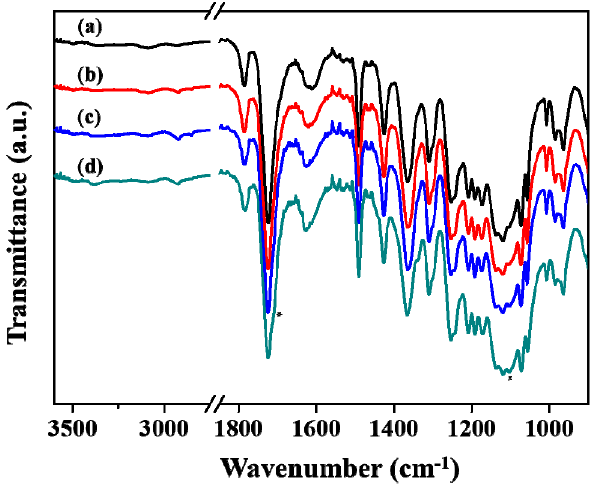
Figure 2. FTIR spectra of the PI and PI–silica composite films with various APTMS contents: (a) pure PI, (b) PI–silica-2.5, (c) PI–silica-5.0, and (d) PI–silica-10.0 films.